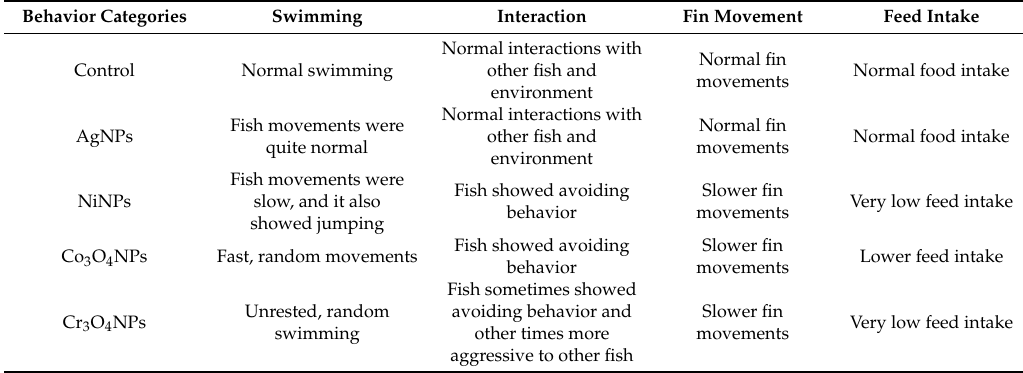
Behavioral manifestation of L. rohita in different experimental groups during the experimental